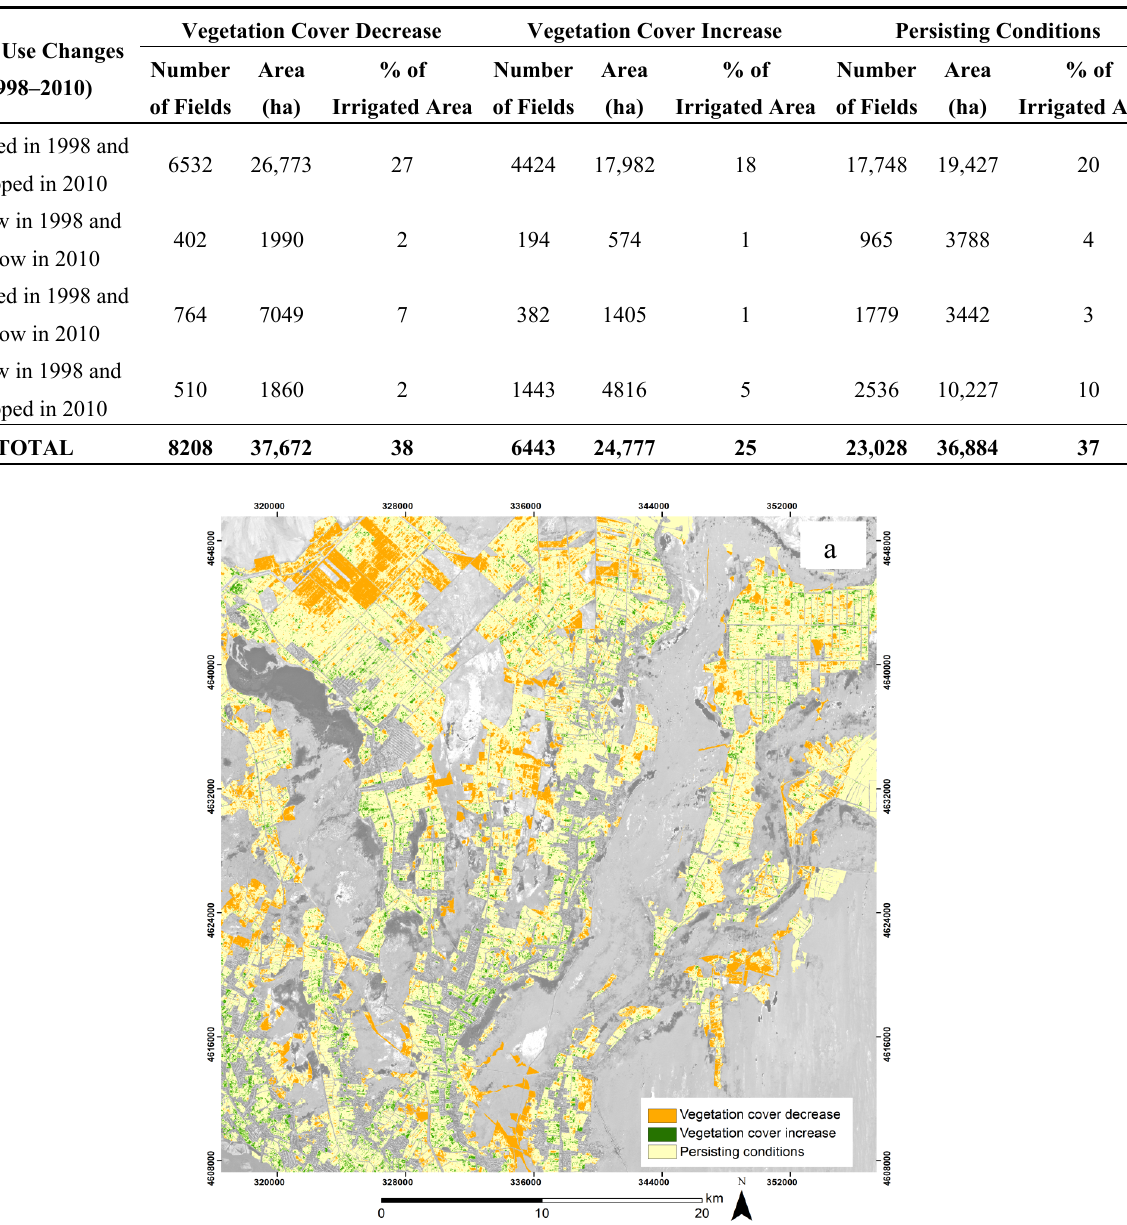
Table 2. Distribution of vegetation cover changes in relation to agricultural land-use changes in 1998 and